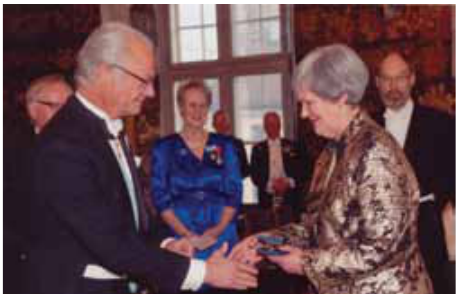
Fig. 4: Helen Clarke receiving the silver medal of the Royal Swedish Academy from King Carl XVI Gustav